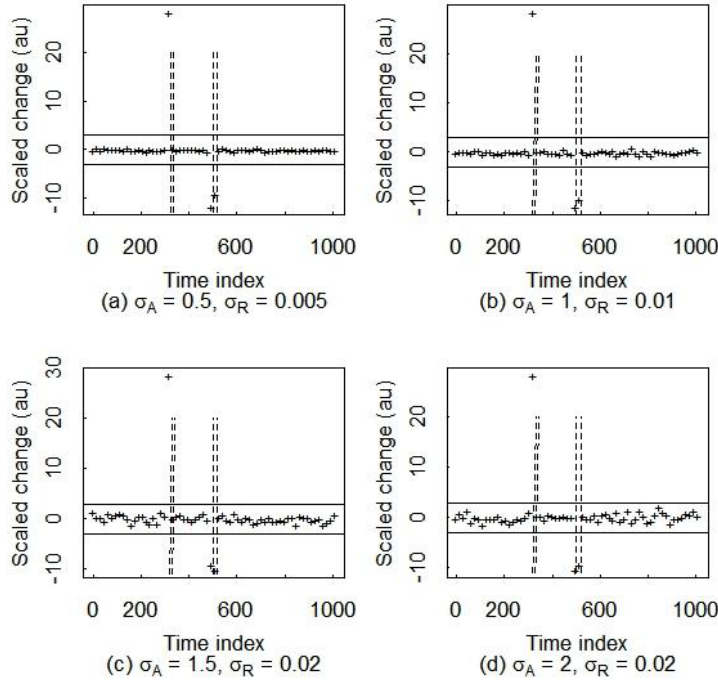
and σ increase. The A R